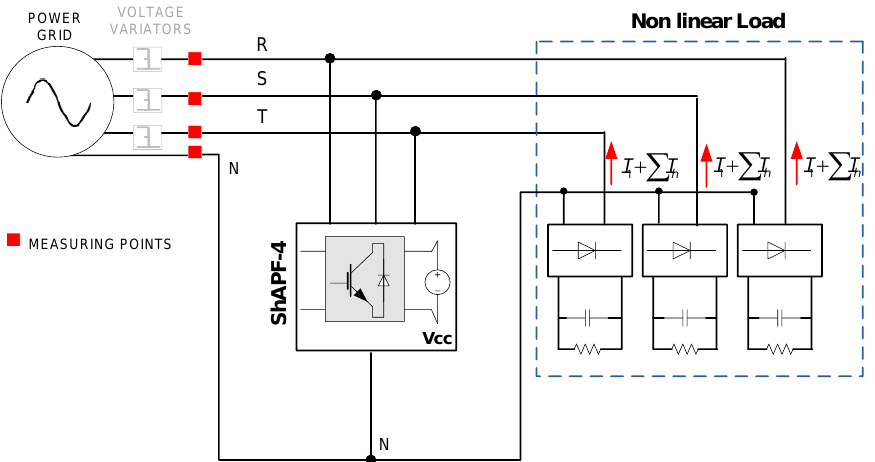
Figure 23. Schematic diagram for experimental studies of the four-wire ShAPF.